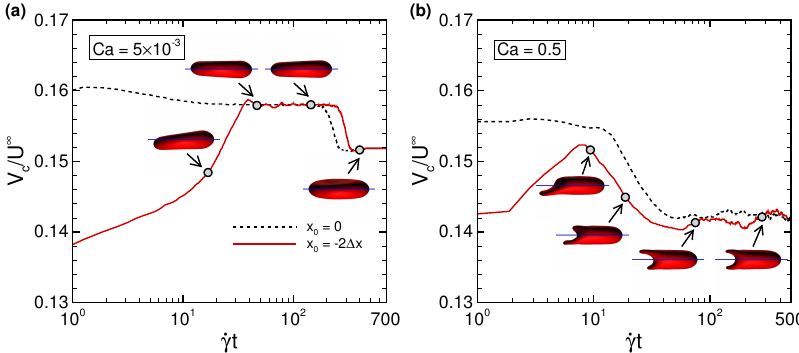
Figure 6. Time history of the RBC centroid velocity ( V c ) at ( a ) low Ca = 5 × 10 − 3 , and ( b ) high Ca = 0.5 for different initial positions along the span-wise direction x 0 , where one RBC is initially placed at the midline of the channel ( x 0 = 0, dashed line) and the other RBC is placed two fluid meshes away from the midline ( x 0 = − 2 ∆ x, red line). The images represent snapshots of the RBC with x 0 = − 2 ∆ x at the indicated times (see also Videos S5 and S6). Note that V c = 12.7 µ m/s for Ca = 5 × 10 − 3 at ˙ γ t = 500 ( t = 60 s), and V c = 1180 µ m/s for Ca = 0.5 at ˙ γ t = 500 ( t = 0.6